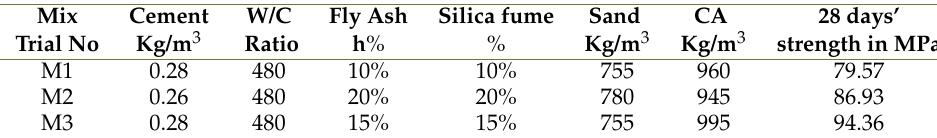
Table 1. Details of selected mix proportions